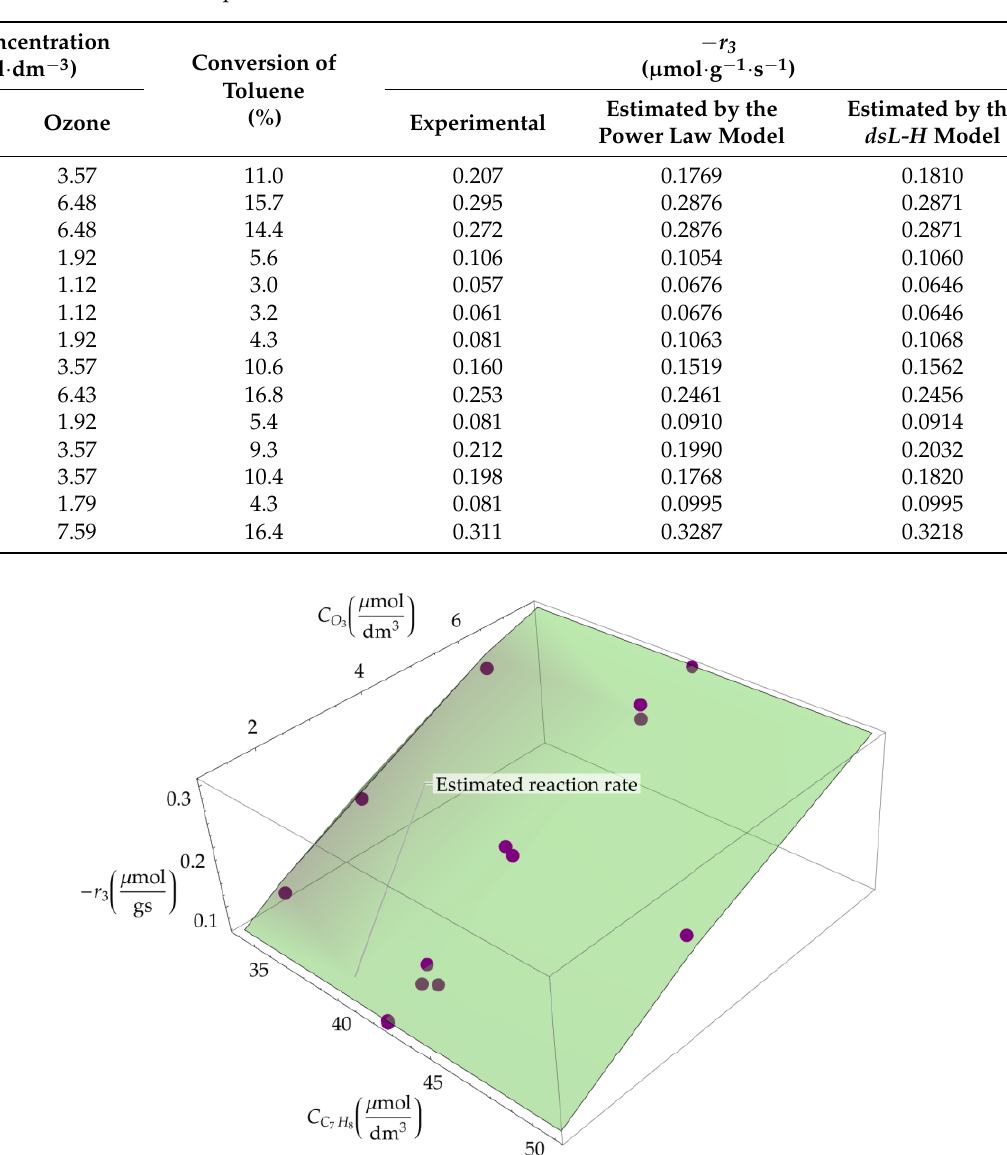
Table 2. Experimental and calculated reaction rate values.